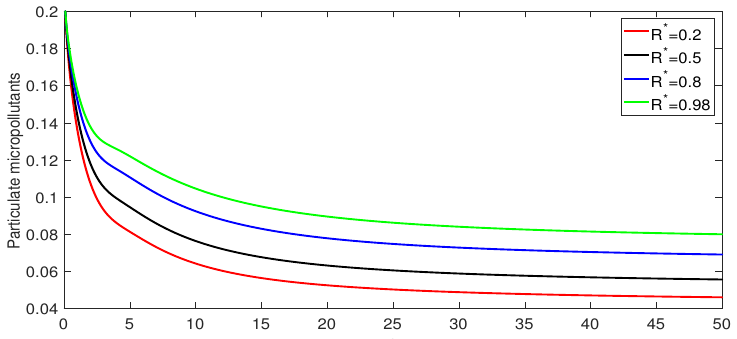
Figure 2. Graphical illustration of the model (8) for δ = 0.8, SMX and various values of recycle ratio.